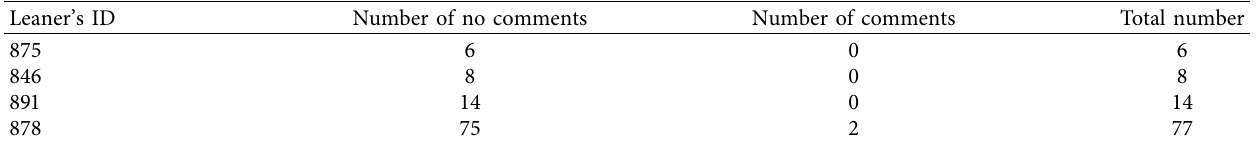
Figure 7: Hotness distribution chart of learner B. Table 2: Comments from learners with an approximate comment index of 0.